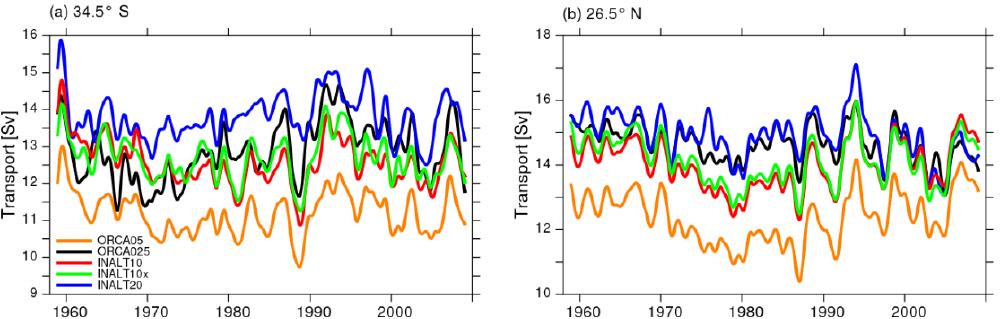
Figure 12. Time series of AMOC transport (in Sv) at 34.5 ◦ S (a) and 26.5 ◦ N (b) from ORCA025 (black), INALT20 (blue), ORCA05 (orange), INALT10 (red) and INALT10x